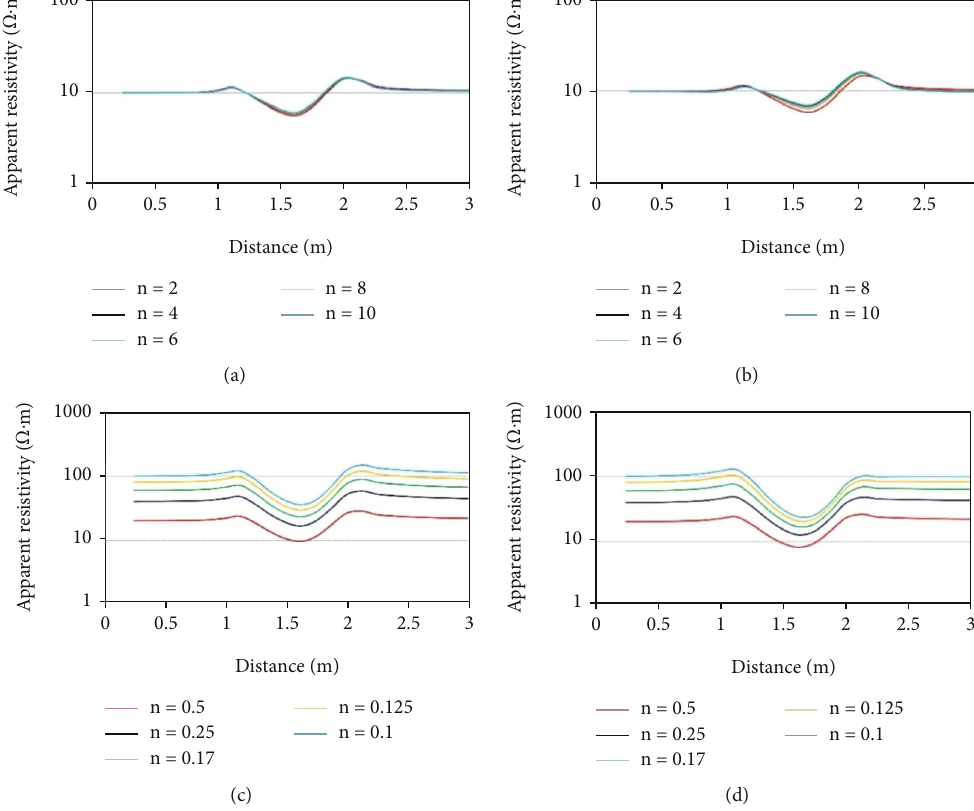
< ρ dy = 5 : 6 m , ter 1 2 and